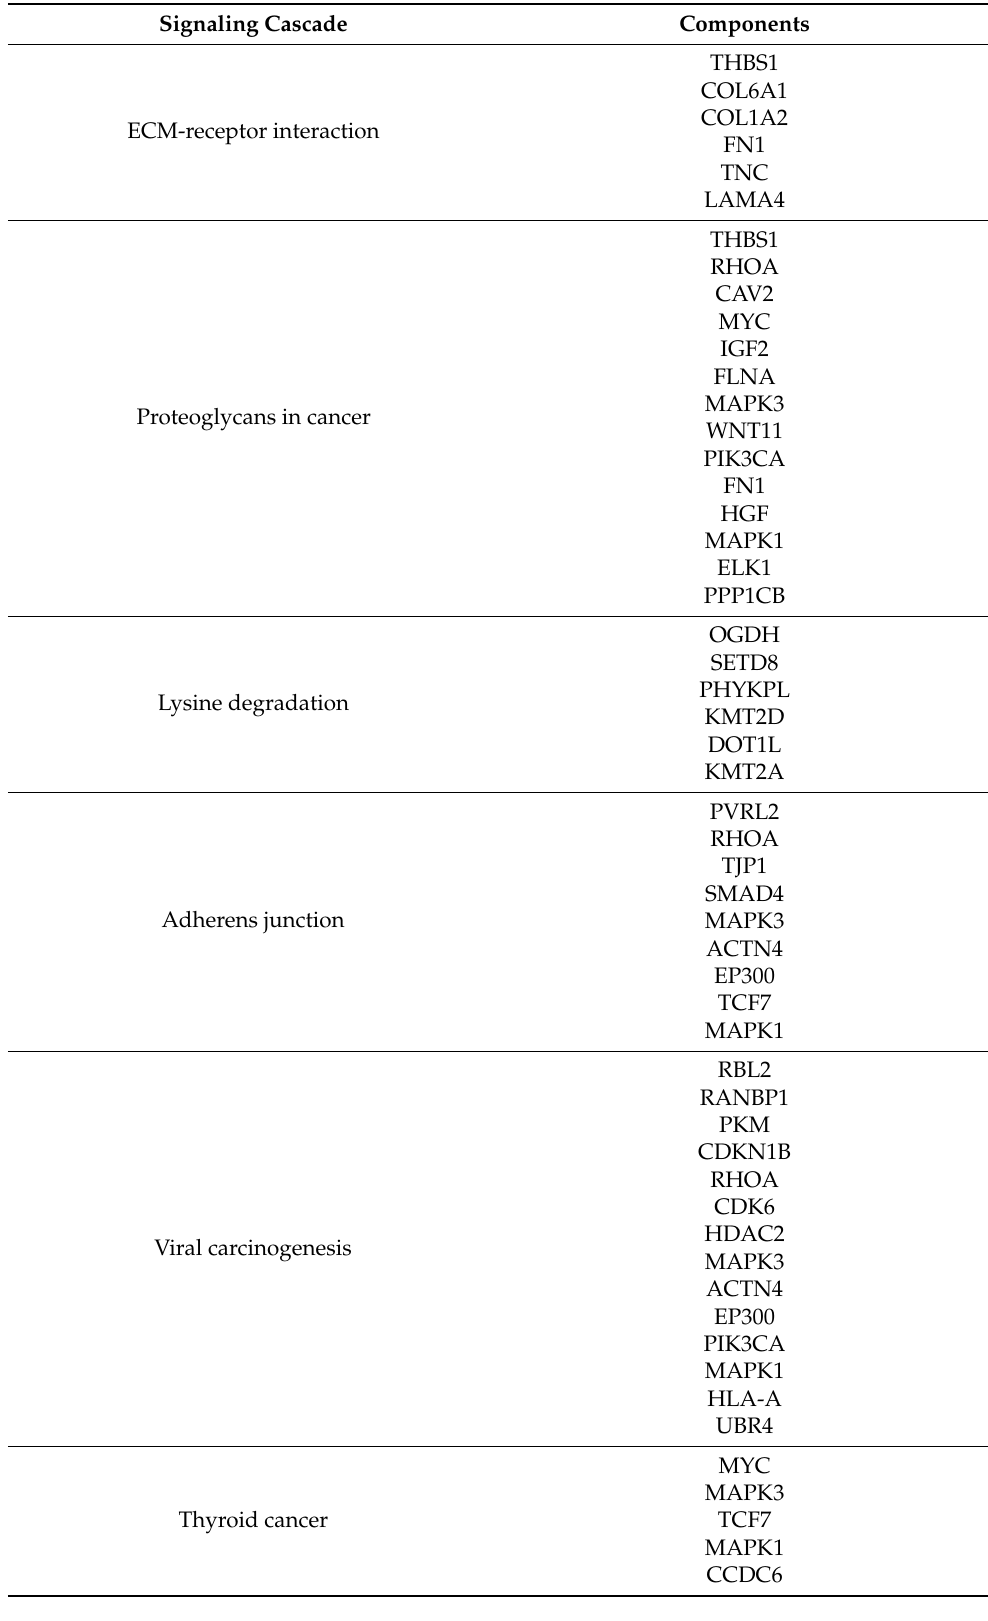
Table 3. The signaling cascades and their components, associated with